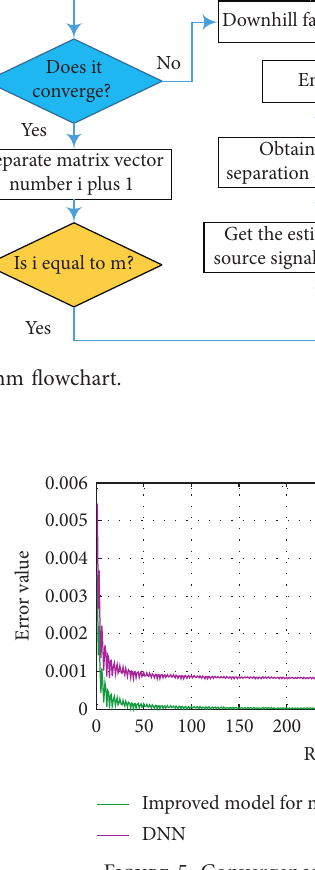
Figure 5: Convergence curve